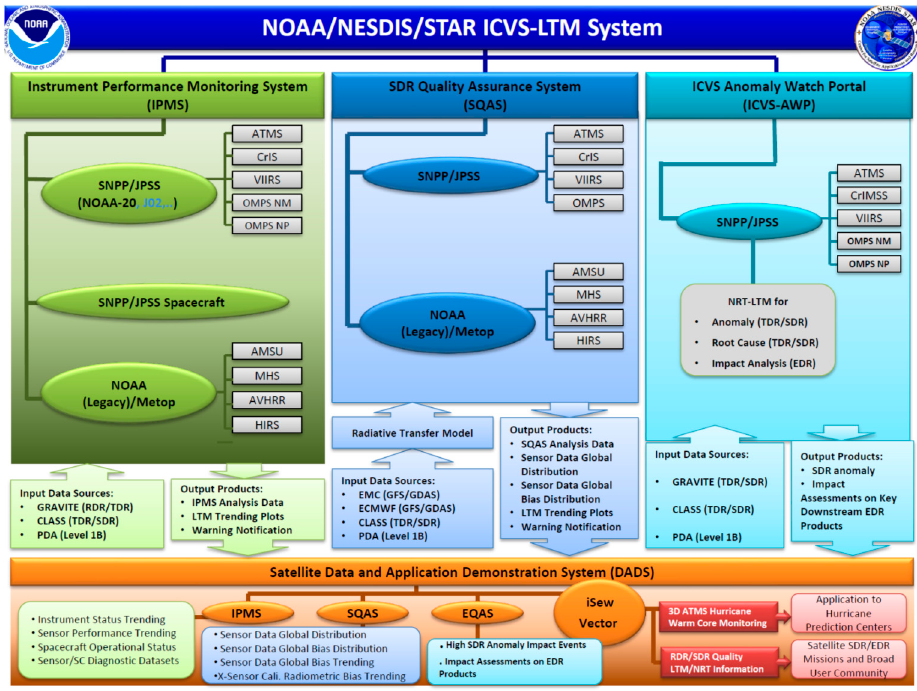
Figure 1. Diagram of the ICVS-LTM, showing three key components: the Instrument Performance Monitoring System (IPMS), the SDR Quality Assurance System (SQAS), and the ICVS Anomaly Watch Portal (ICVS-AWP) (https://www.star.nesdis.noaa.gov/icvs/index.php, accessed on 5 April 2021), as well as the associated Satellite Data and Application Demonstration System (DADS) which includes the ICVS Severe Weather Event Watch (iSEW).